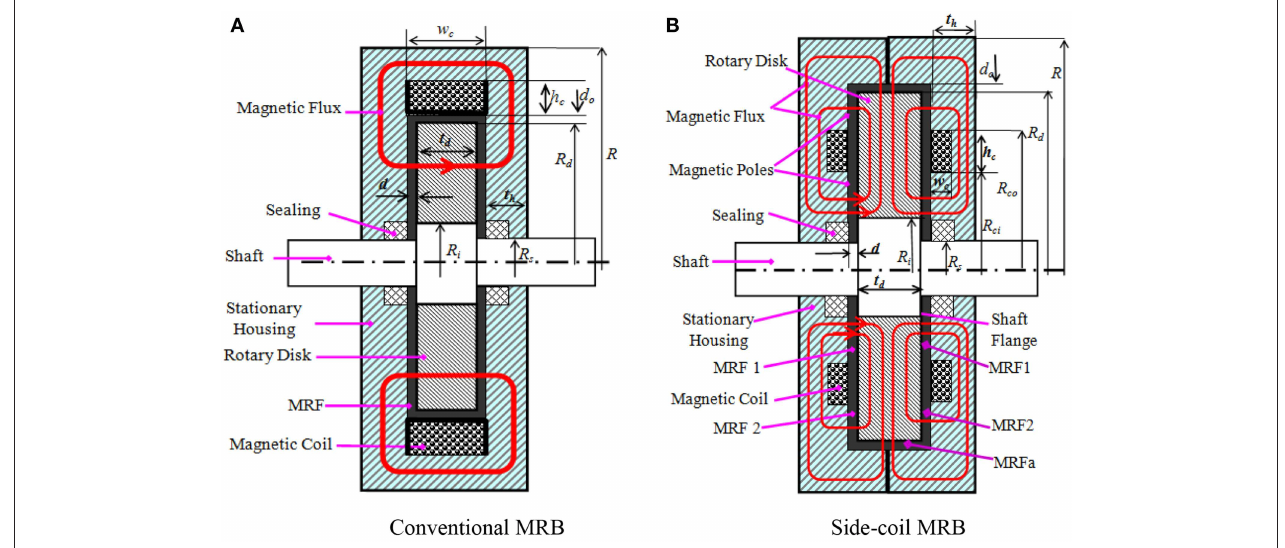
FIGURE 1 | Configurations of the conventional and the side-coil MRBs. (A) Conventional MRB. (B) Side-coil